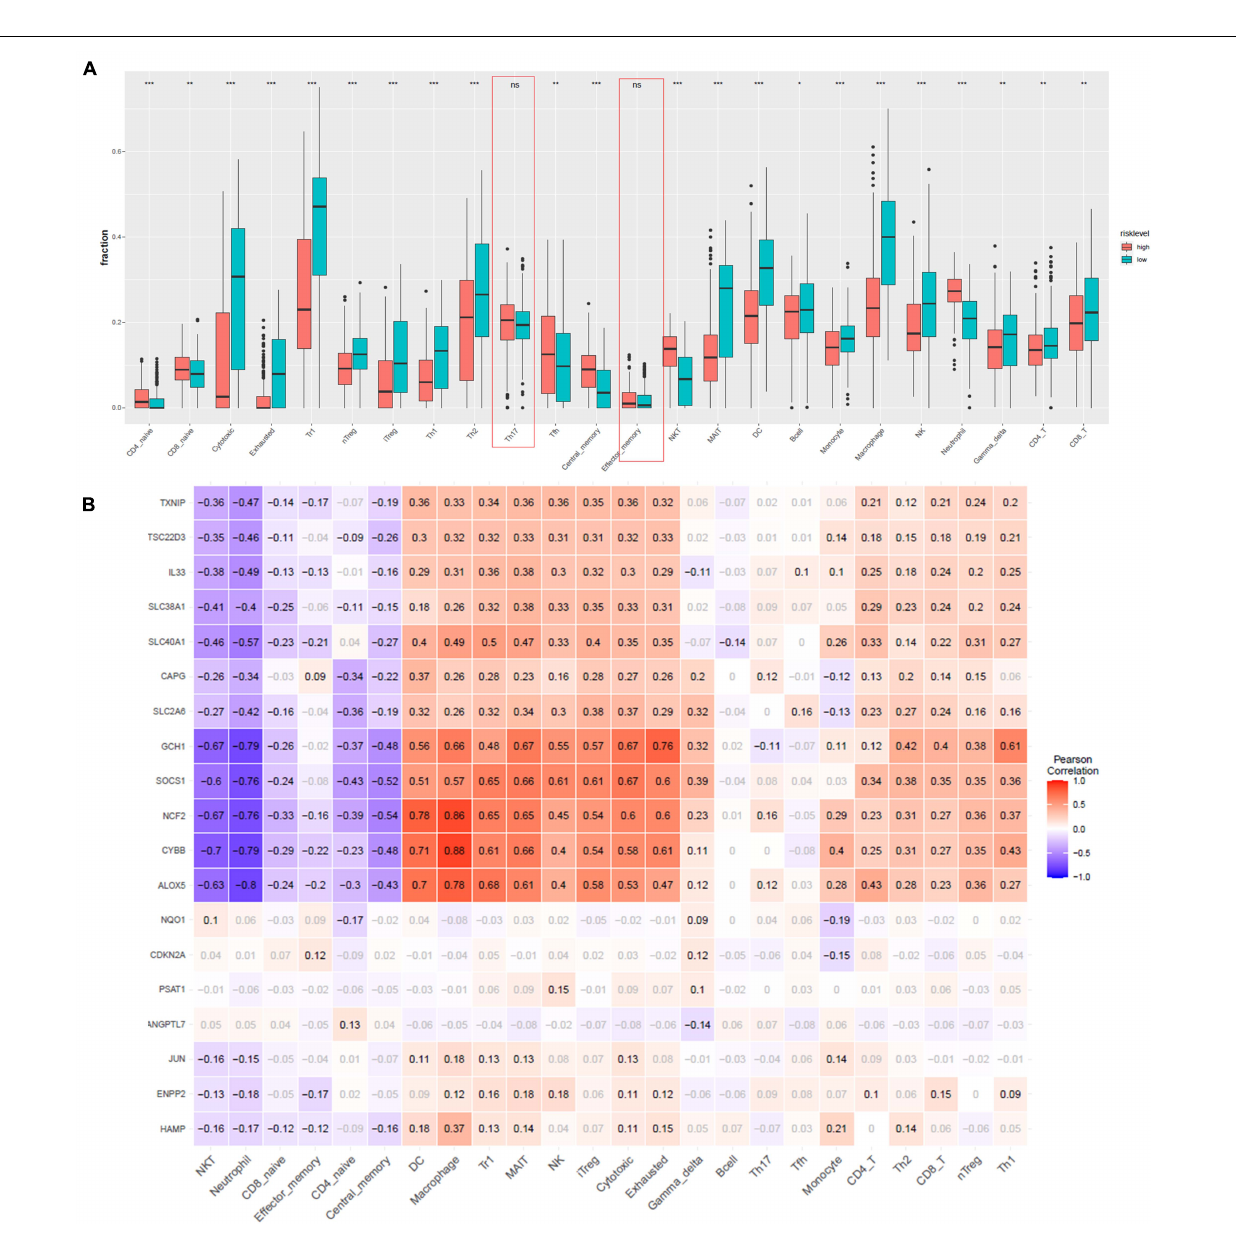
Frontiers in Genetics |